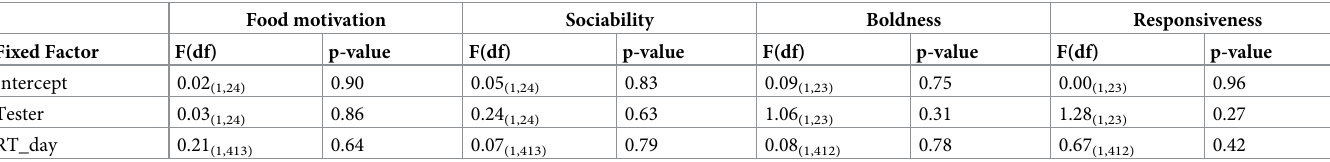
Table 6. Linear Mixed Model output. Main effect of tester and reactivity test day (RT_day) on the four main component scores extracted from the